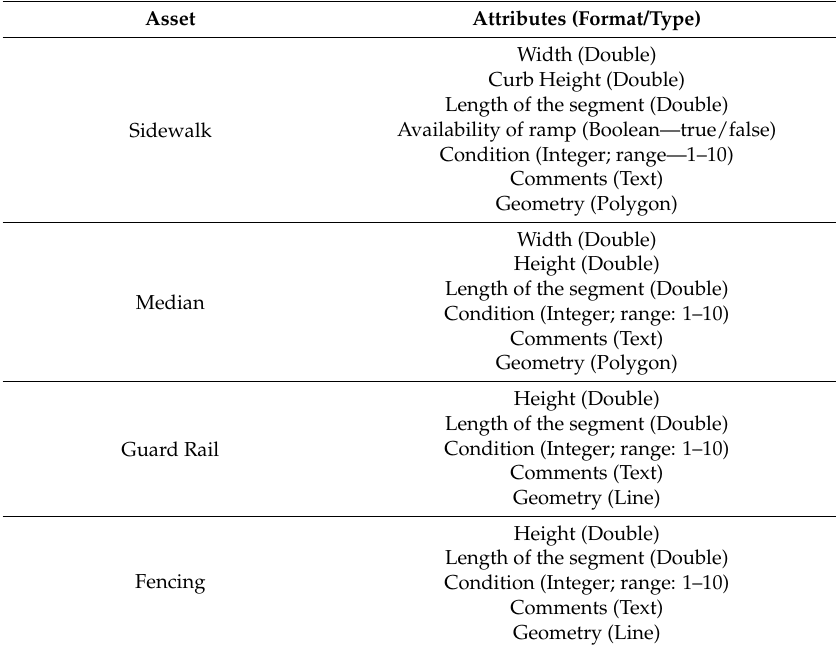
Table 1. Asset attributes stored in a GIS